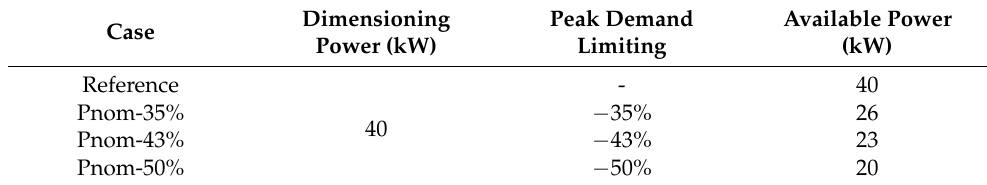
Table 6. Peak demand limiting cases.